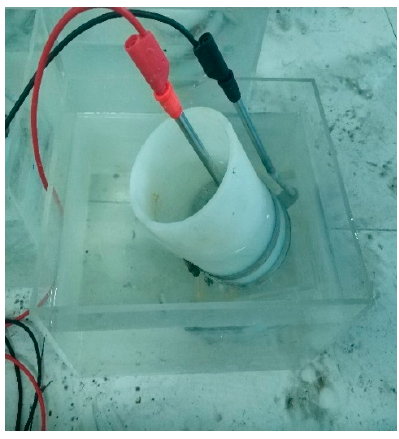
Figure 8. Tank of test.